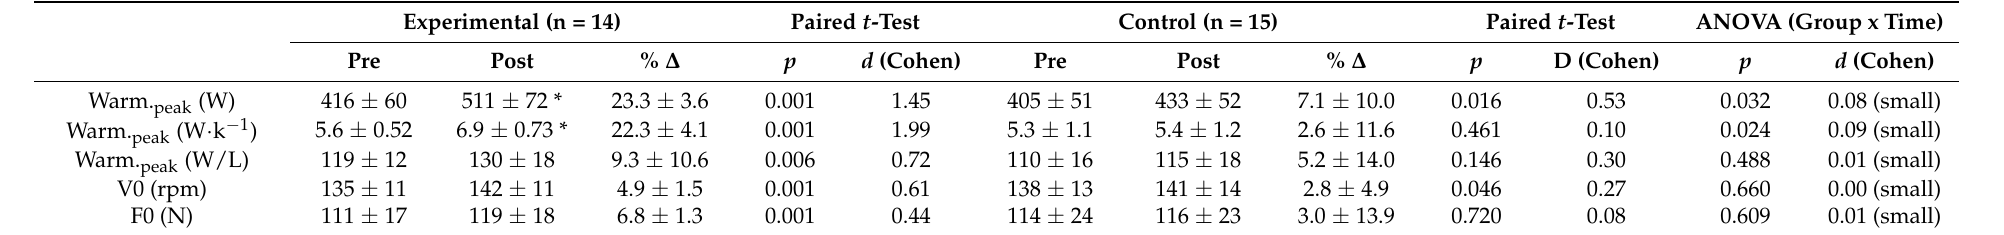
Table 4. Force–velocity test data for the upper limbs for the experimental and control groups before and after an 8 week intervention.